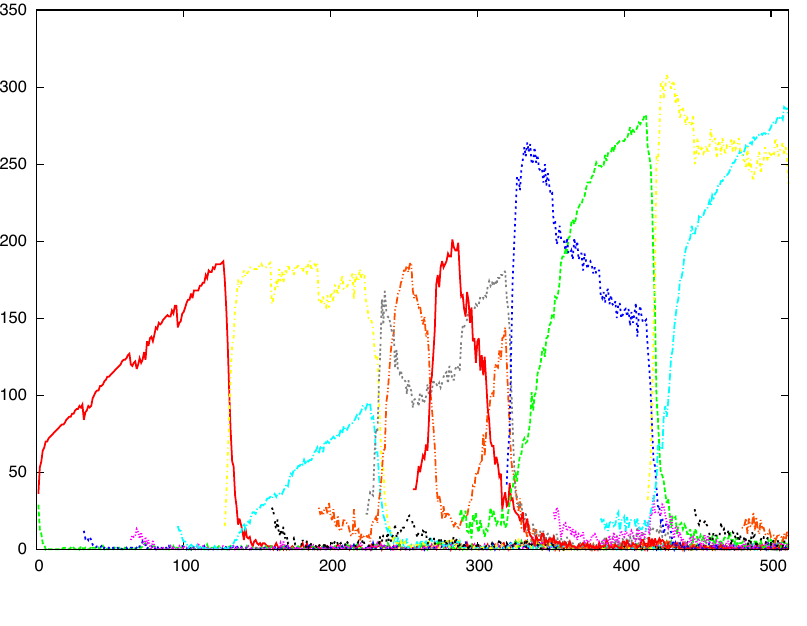
Figure 9. Development of the number of adherents to the different institutions (shown in different colors) for stochastic progress factors, ↵ , distributed uniformly between 1 . 0 and 3 . 0 (compare to Figure